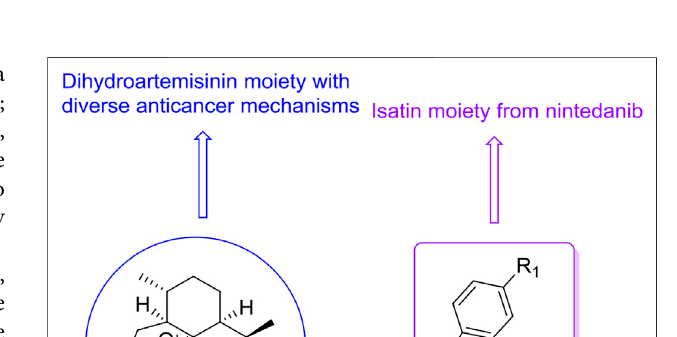
FIGURE 1 | Chemical structures of artemisinin, dihydroartemisinin and isatin.